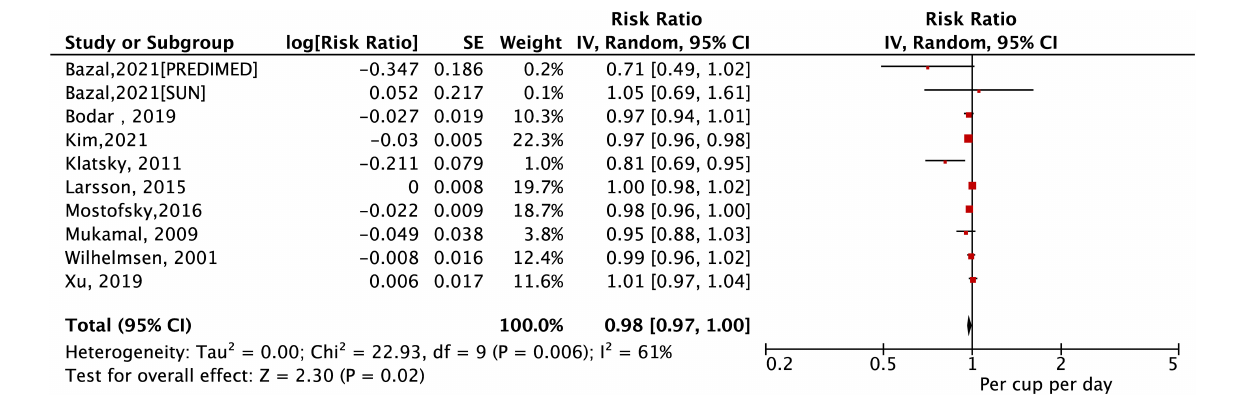
FIGURE 3 | The association of a per cup/day increase in coffee consumption with the risk of atrial fibrillation.